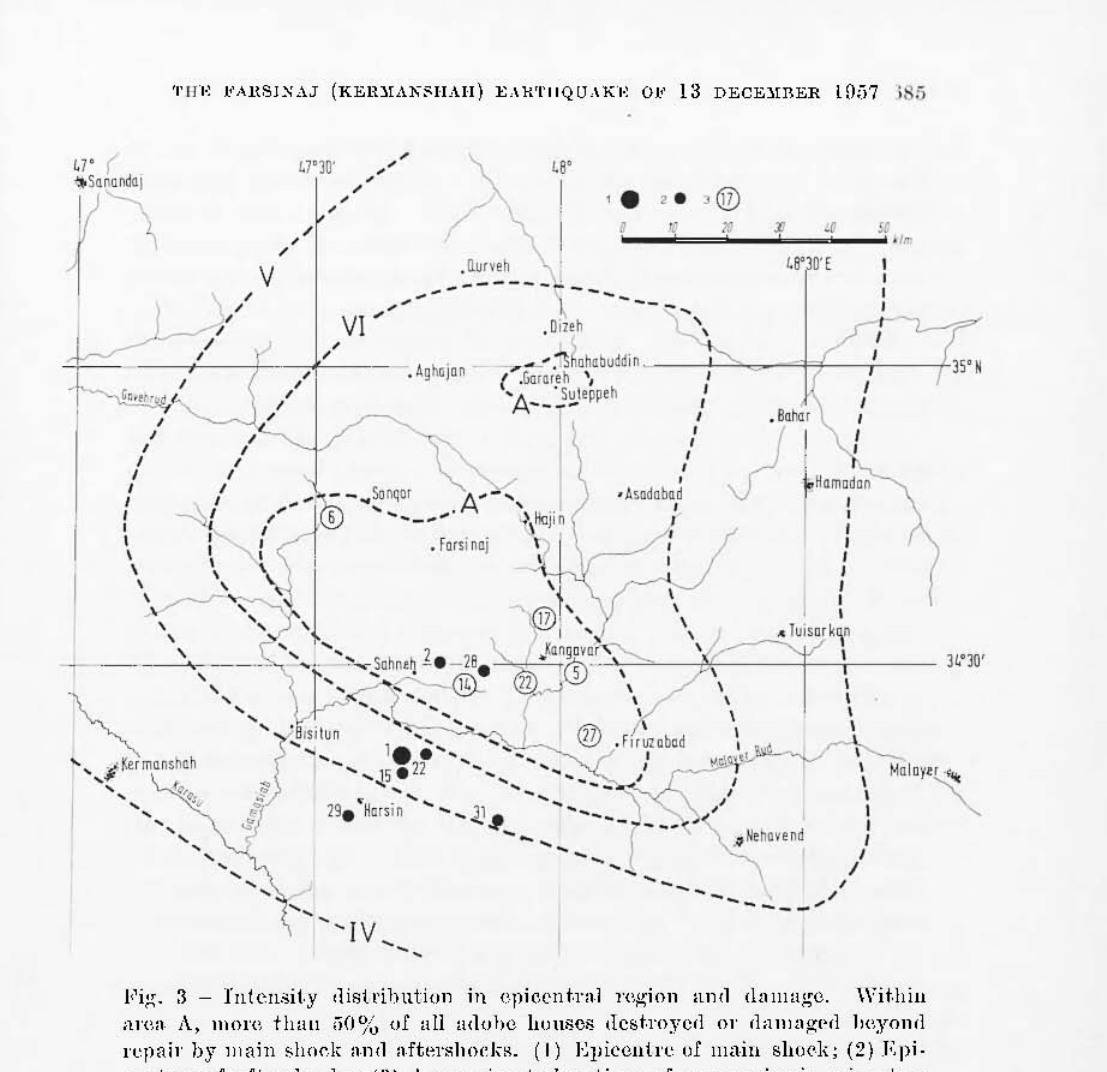
Fig. 3 - rlltell.~it.y ,1istrihutioll in epkenb-nl ]'(\g-ion am] Il:llnng-c.